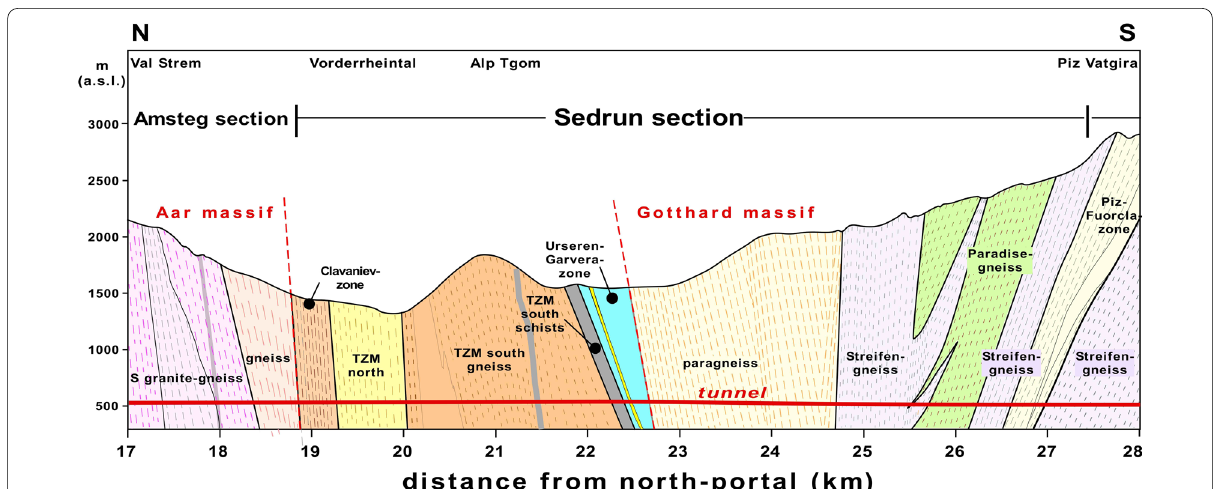
Fig. 2 Geological cross section along the investigated tunnel section Sedrun. Triassic Röti dolomite marble of the Urseren-Garvera Zone (UGZ) highlighted in